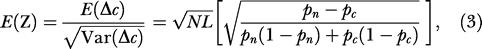
A Measure of Statistical Strength As a Function of Neutral Evolutionary DistanceOne convenient threshold-independent measure of the strength of a comparative analysis is an expected Z score, the expected difference Δc in the number of substitutions in a neutral feature alignment versus a conserved feature alignment, normalized to units of standard deviations. E(Z) is readily calculated for the binomial distribution:

where pn and pc are the probabilities of observing a change at one aligned comparative nucleotide according to the Jukes-Cantor equation.The plots here are for N = 5 and L = 8. The shape of the curve is independent of N and L, while the absolute magnitude of Z scales as √NL
. The x-axis is shown from D = 0 to D = 4, beyond the more realistic range of Figures 1 and 2, to show the mathematically optimum D if homologous conserved features were present, recognized, and accurately aligned at any D.